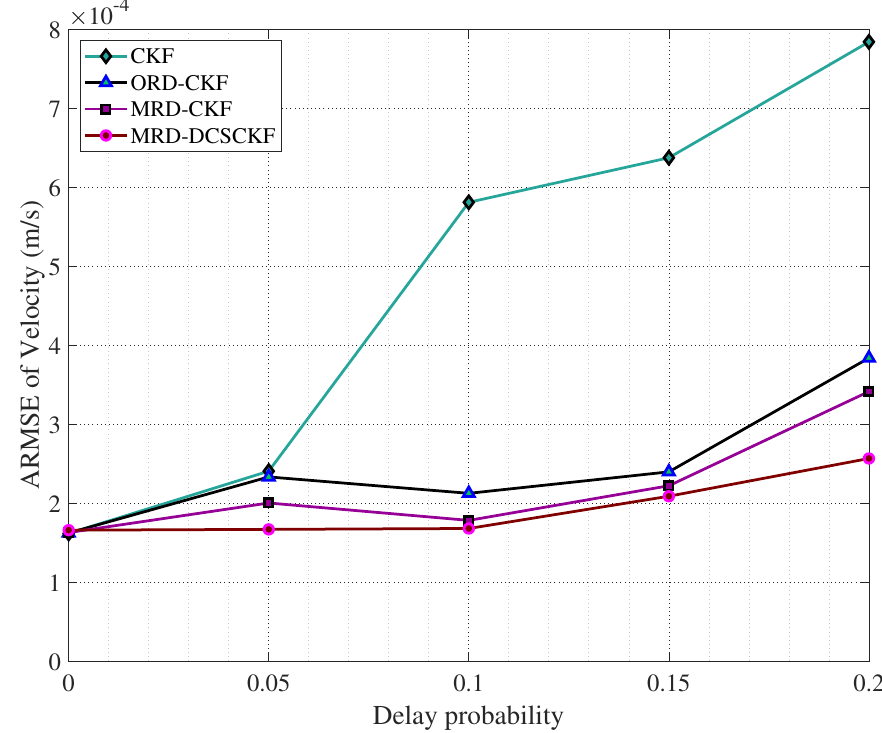
Figure 17. ARMSEs of velocity under different delay